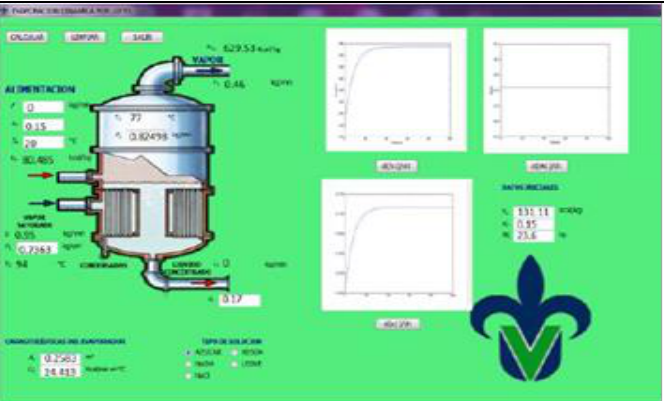
Figura 2: Interfaz gráfica de usuario de la evaporación de simple efecto en operación por lotes.